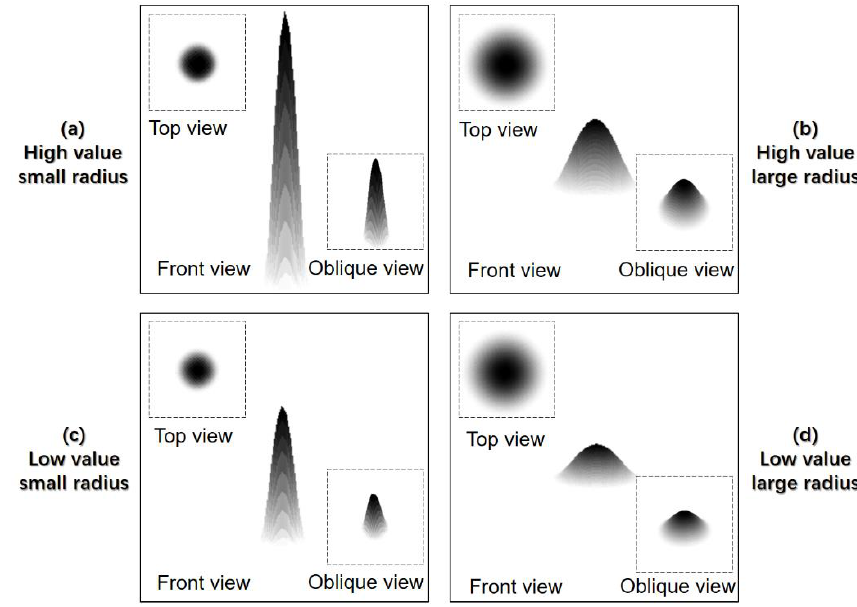
Figure 5. Different perspectives of terrains of different parameters.